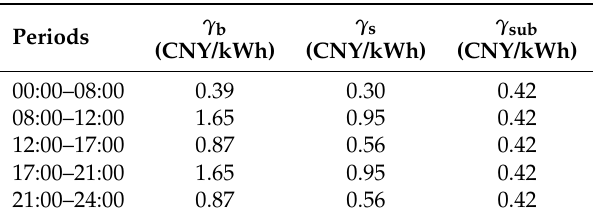
Table 4. Time-of-use price in a day.